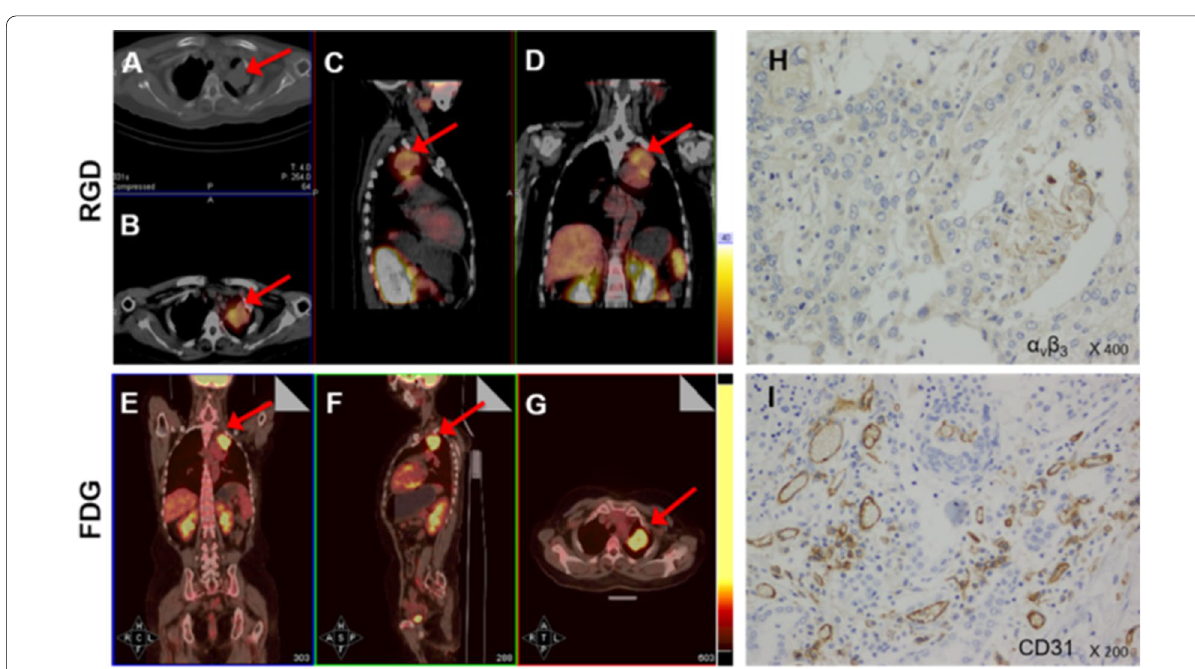
Fig. 8 [ 99m Tc]Tc-Galacto-RGD 2 SPECT/CT showed RGD-avid lesion in a female patient with squamous cell carcinoma. a – d RGD imaging showed focal uptake in the left lung. e – g FDG-avid lesion shown in the left upper lung. h , i IHC showed a moderate α v β 3 expression in the tumour cell membrane, and a high density of neovascularization with high expression of